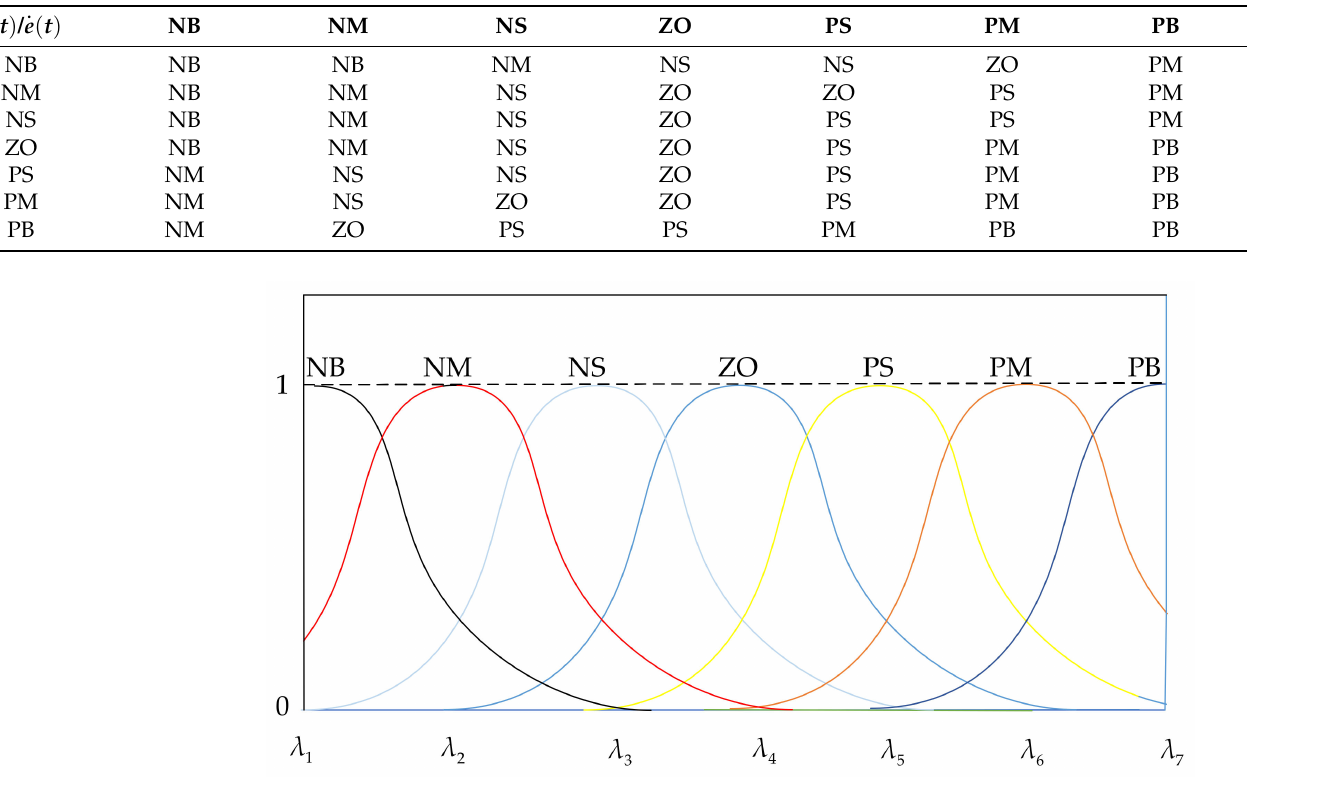
Figure 4. Membership function for position error.